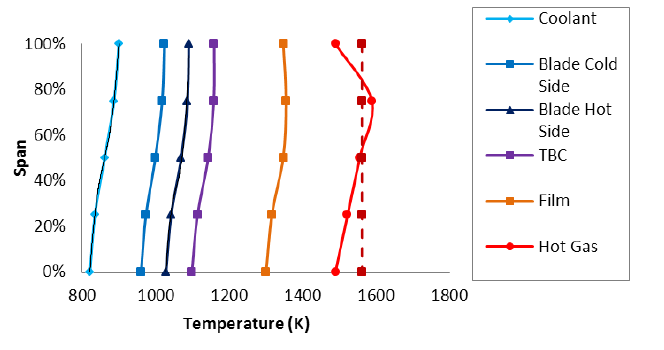
Figure 5: Span wise temperature profiles at take-off conditions.